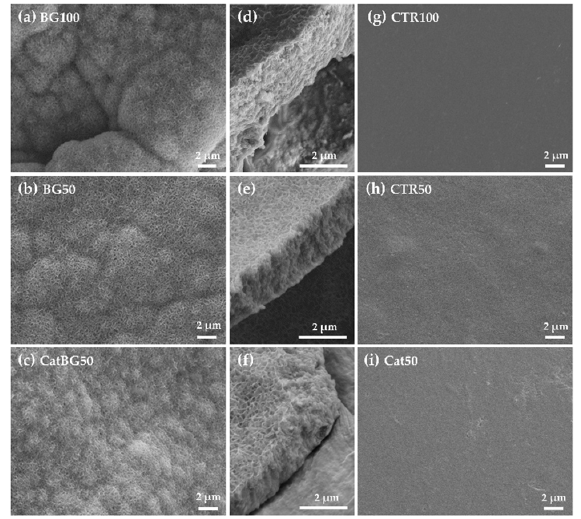
Figure 13. SEM images ( a ), ( b ) and ( c ) of the surface of the bioactive LbL films after immersion in SBF for 14 days, where ( d ), ( e ), and ( f ) present a cross-sectional view of the apatite layer formed onto the films’ surface. ( g ), ( h ) and ( i ) present the surface of the non-bioactive LbL films. Molecules 2020 , 25 , x FOR PEER REVIEW